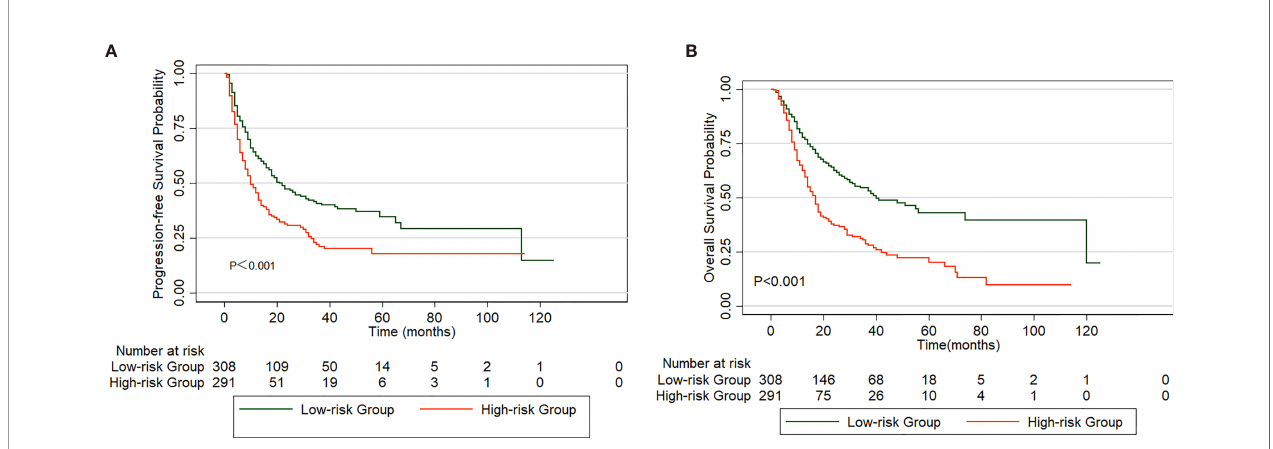
FIGURE 3 | Comparison of PFS (A) and OS (B) in patients divided into high and low-risk group based on a clinical scoring model.